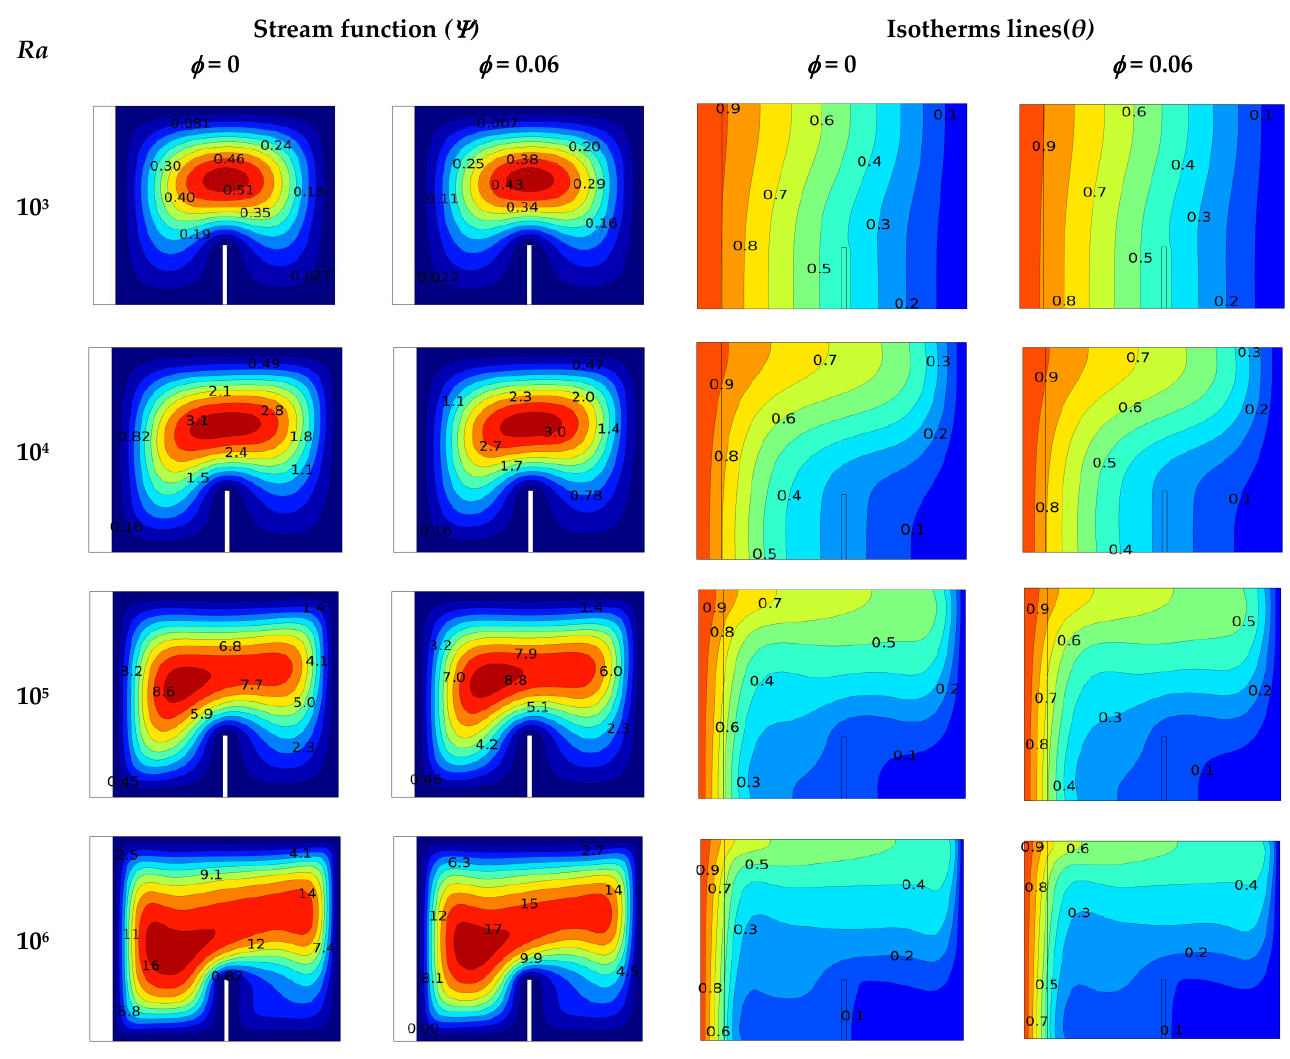
Figure 5. Effect of Rayleigh number on streamlines and Isotherms for different volume fraction, 𝐾𝑟 = 1 and  = 90. Kr = 1 and Φ =